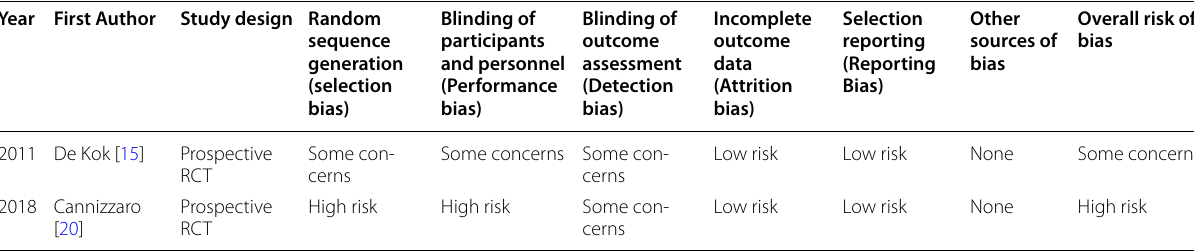
Table 4 Cochrane risk of bias (RoB 2) tool for randomised controlled